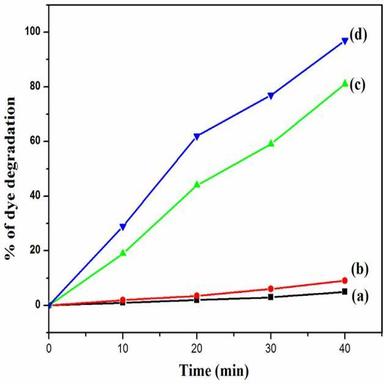
The effect of pH = 7 Photodegradation study of NBB dye under UV-light irradiation at 365 nm by (a) Dark (b) Nil catalysis (c) SnO2 and (d) CdO-SnO2 nanocomposite material.